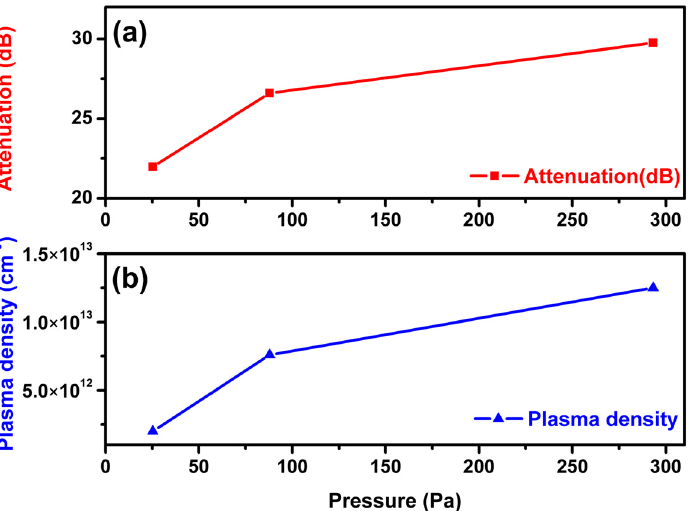
Figure 7. Comparison graph of maximum attenuation value and plasma density measurement result